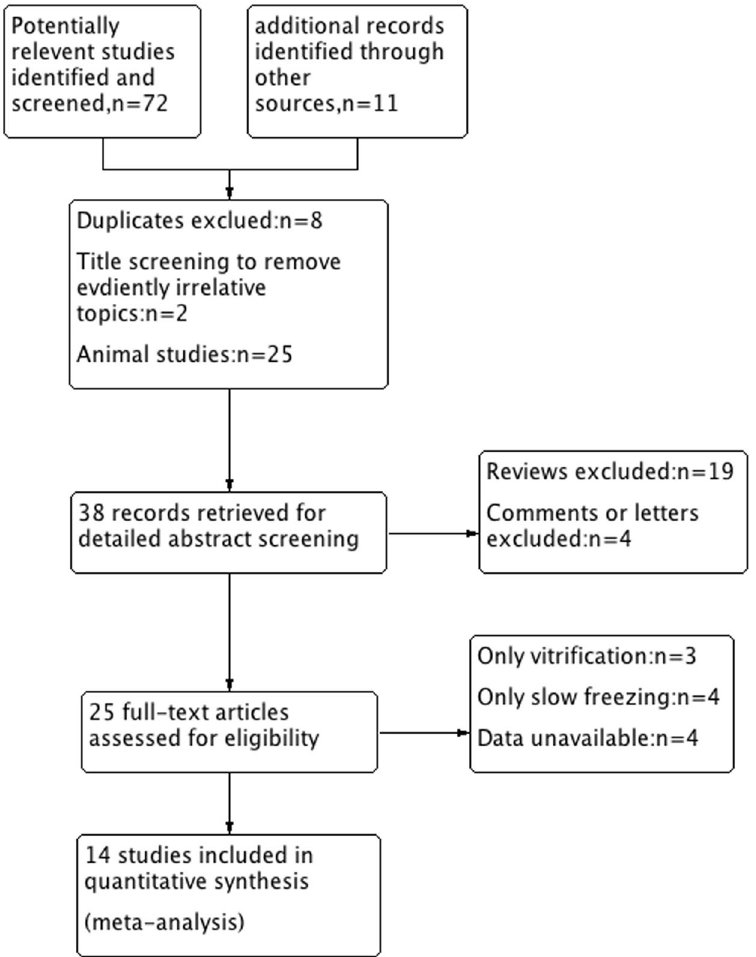
Figure 1. Flow diagram of the study selection